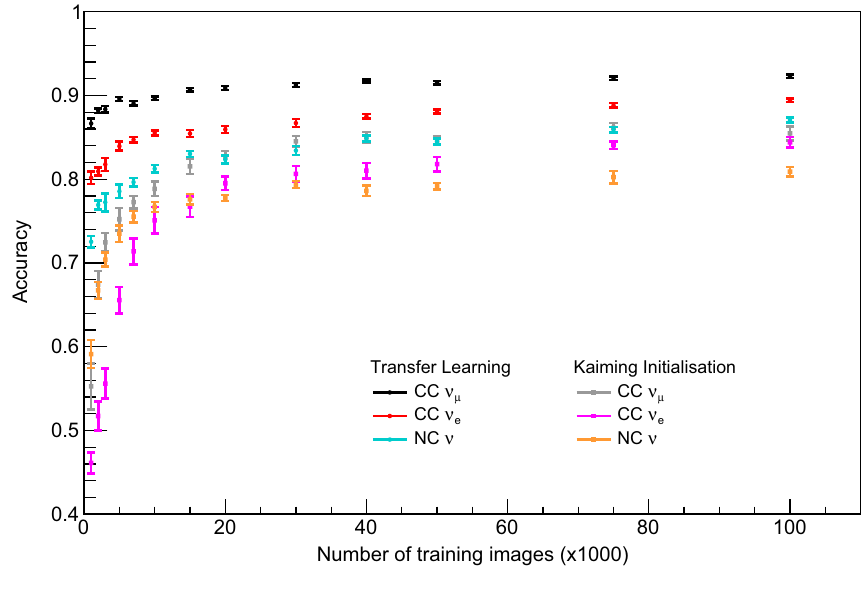
Fig. 5 The accuracy for the three classes (CC ν μ , CC ν e and NC) for the transfer learning all weights and Kaiming-initialised networks. The error bars show the uncertainty on the mean accuracy from the ensembles of 25 trained networks for each point